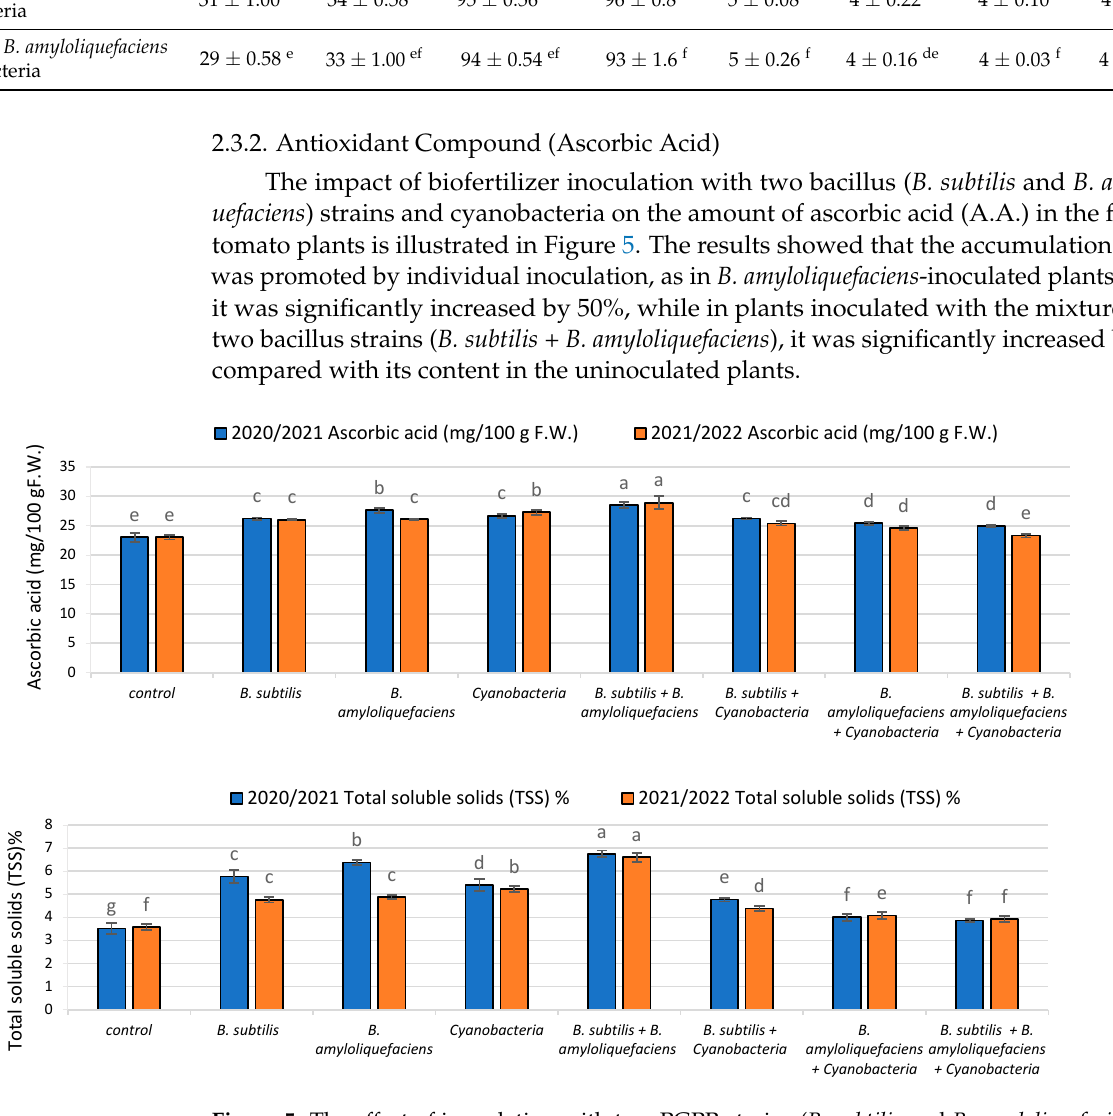
Figure 5. The effect of inoculation with two PGPR strains ( B. subtilis and B. amyloliquefaciens ) and cyanobacteria on Ascorbic acid content (mg/100g F.W.) and the Total soluble solids (TSS) % of tomato plants in two seasons (2020/2021) and (2021/2022). Different letters indicate significant differences between treatments (ANOVA, LSD, p < 0.05). Error bars represent standard error of the mean.